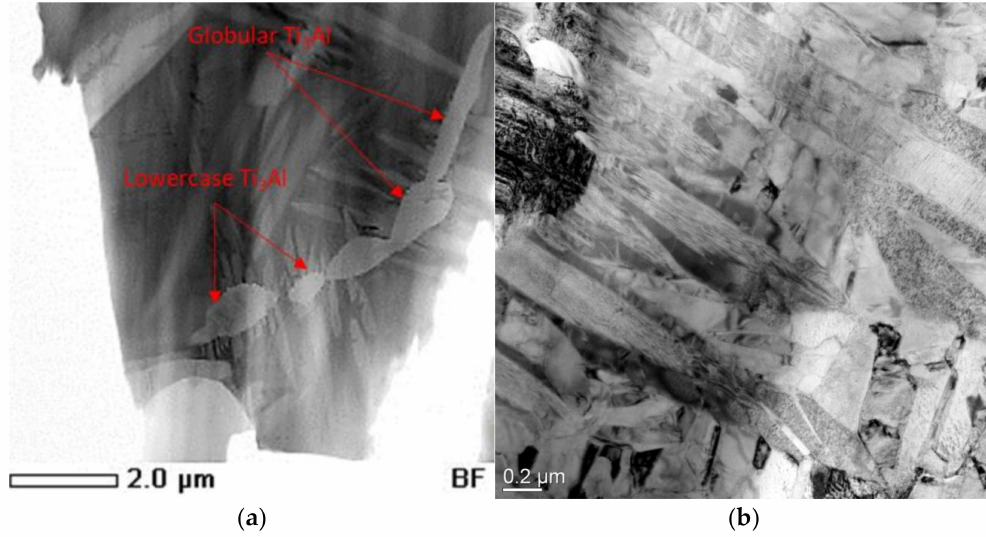
Figure 10. Fine structure of the alloy of the Ti-25Al25Nb at.% system: ( a ) STEM; ( b ) TEM.